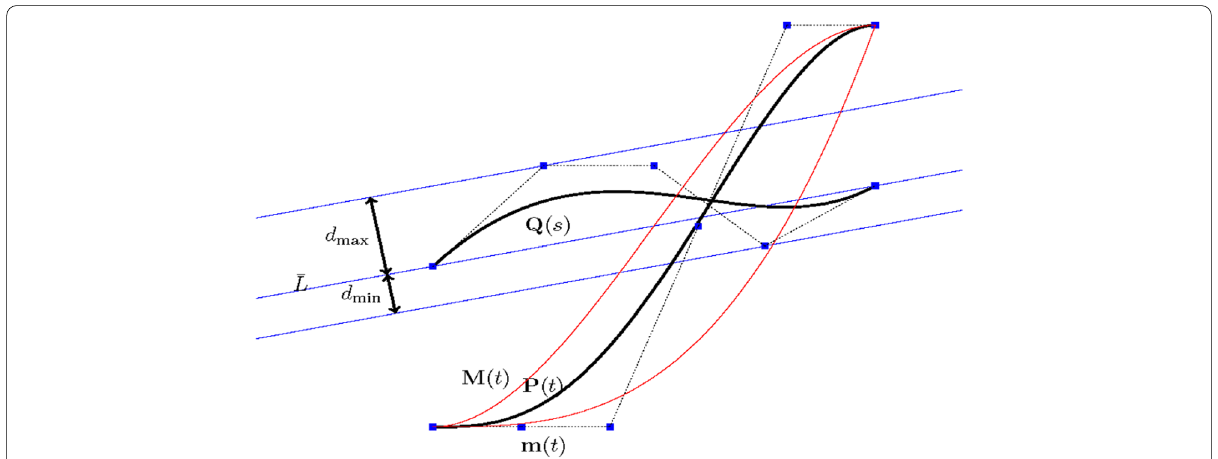
Fig. 2 Intersection of cubic strip [ m , M ] of P and fat line L Q of